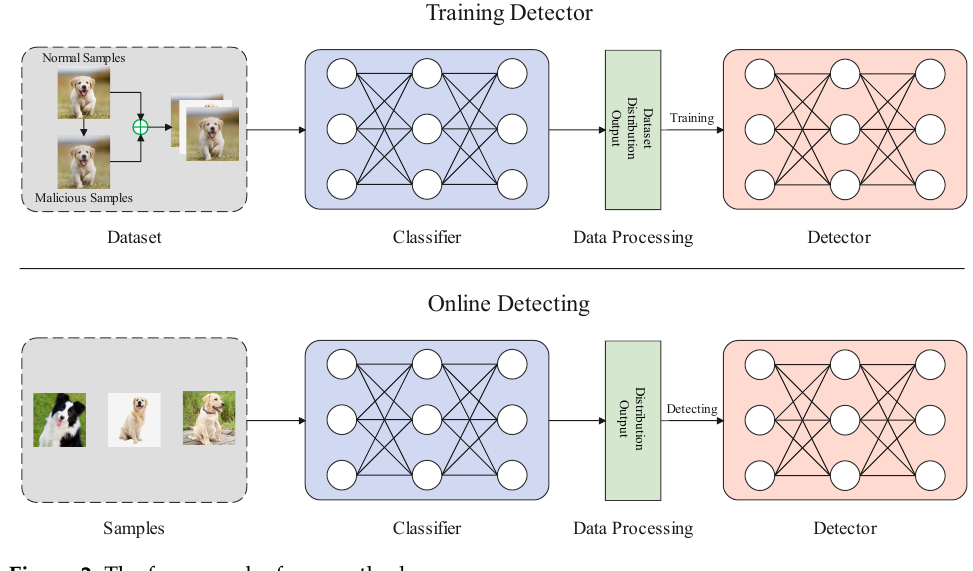
Figure 2. The framework of our